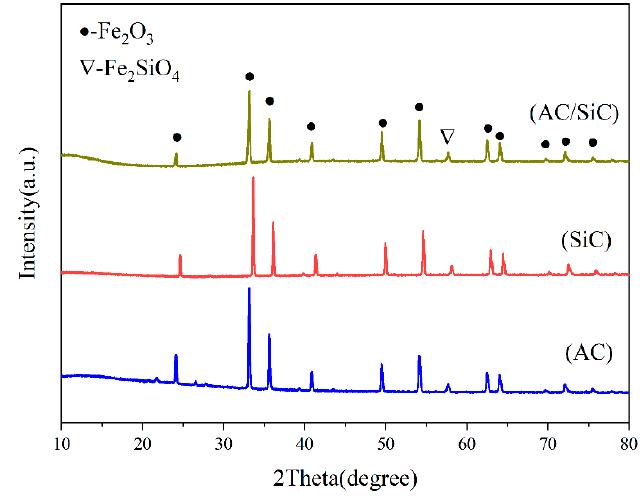
Figure 10. XRD of samples prepared at different heating